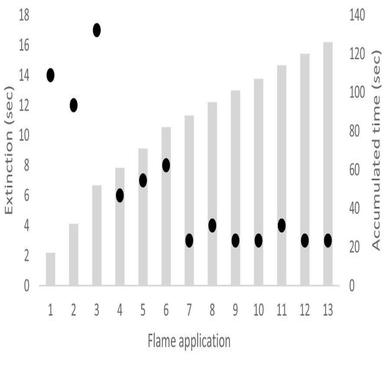
Extinction times and accumulated test times.